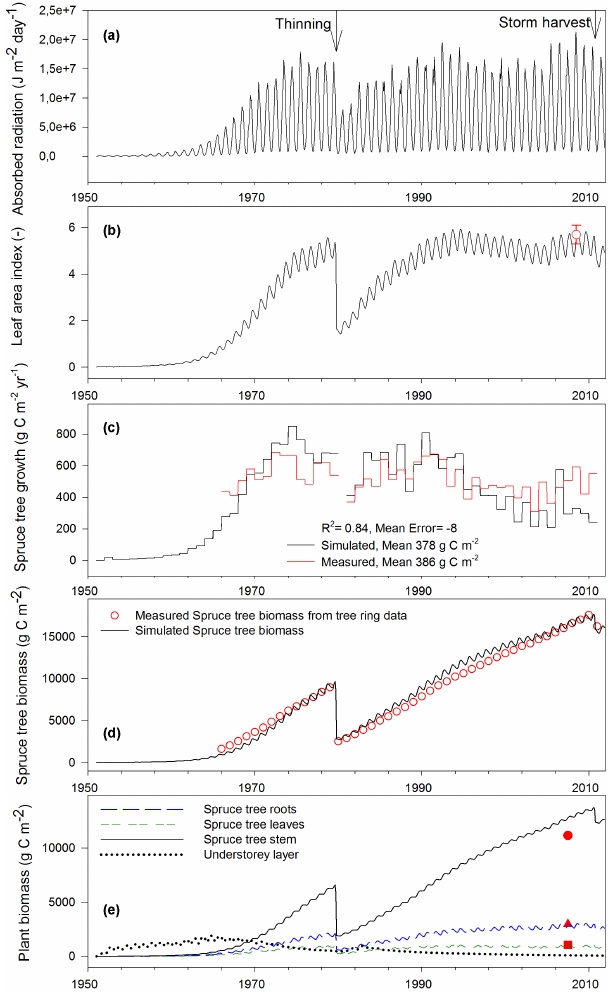
Figure 2. (a) Simulated (black line) spruce absorbed radiation; (b) simulated and measured (red hollow circle) leaf area index; (c) annual spruce tree growth rate; (d) total spruce tree biomass; (e) spruce tree biomass for different components. In (e) the solid red symbols show the calculated plant biomass of leaf biomass, root and stem biomass using the allometric function given by Meyer et al.